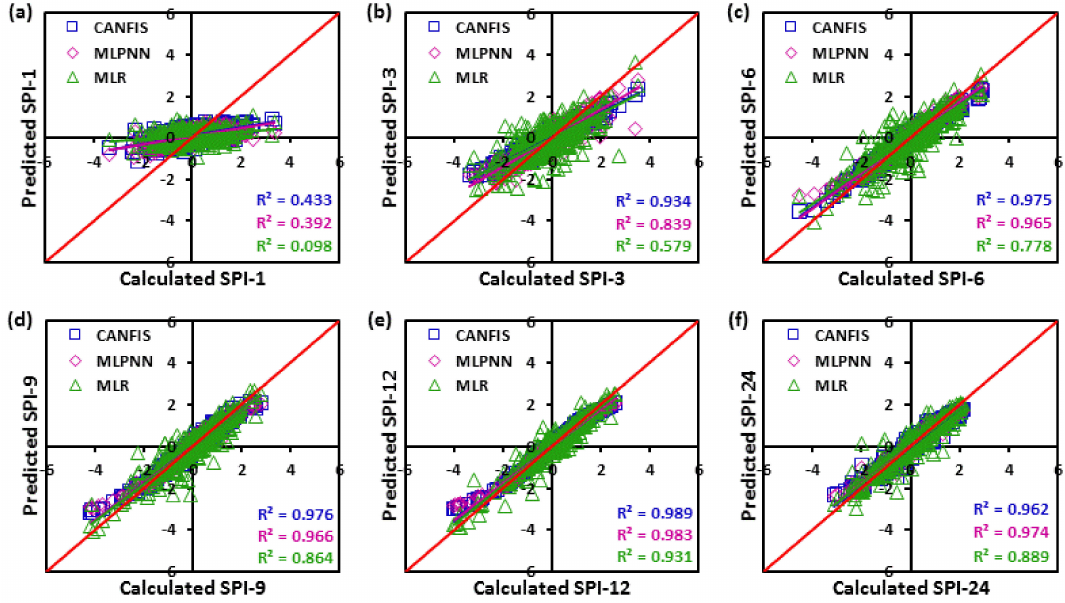
Figure 4. ( a – f ) Scatter plots of calculated and predicted multi-scalar SPI values by CANFIS, MLPNN, and MLR models during the testing period at Chamoli station.